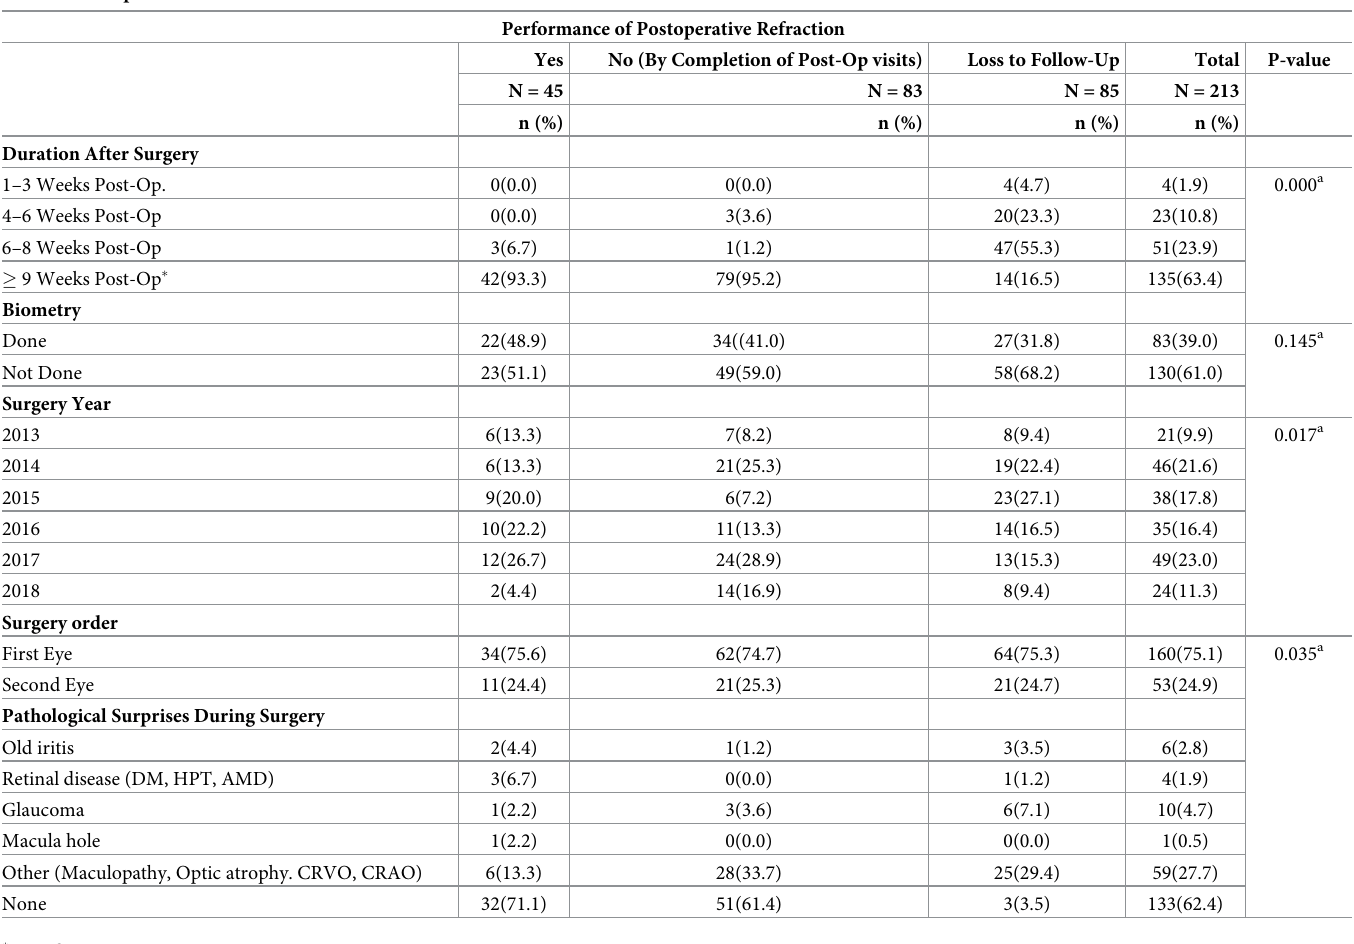
Table 3. Postoperative